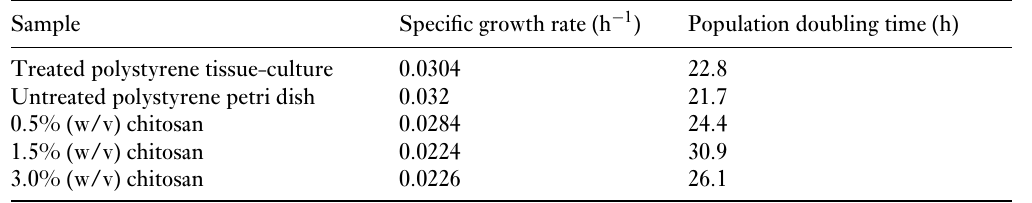
Table 3 NIH-3T3 growth parameters on different surfaces